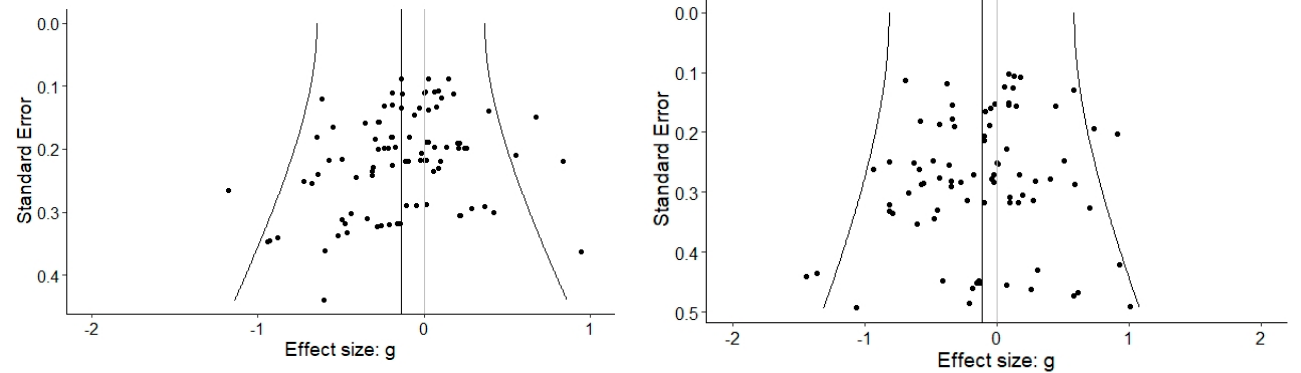
Figure 6. Three-Level Funnel Plots of TLMA 1 ( Left ) and TLMA 2 ( Right ). Note. The black dots represent effect sizes of individual biomarkers (Level 2), plotted against their standard errors. Asymmetry indicates possible publication bias.